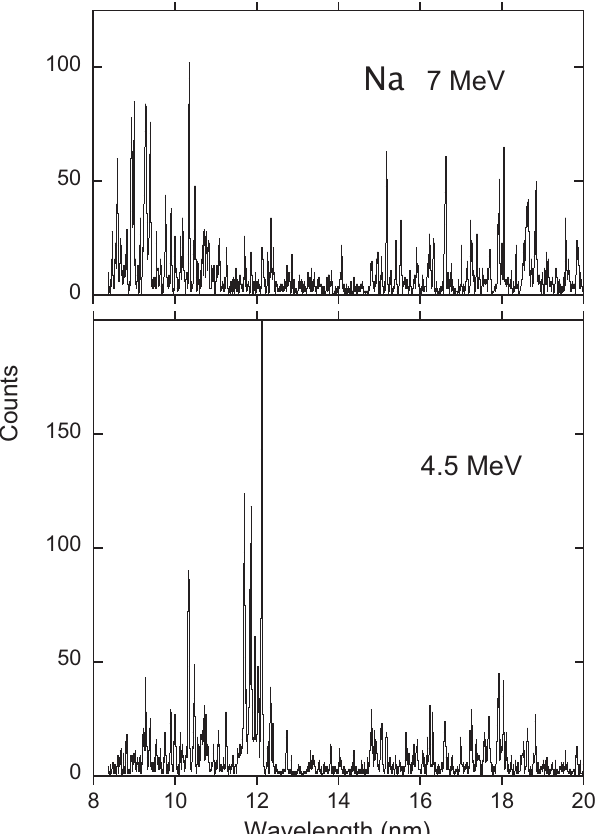
Figure 3. Beam-foil spectra of Na at ion beam energies of 7 MeV (top) and 4.5 MeV (bottom) (unpublished data collected for